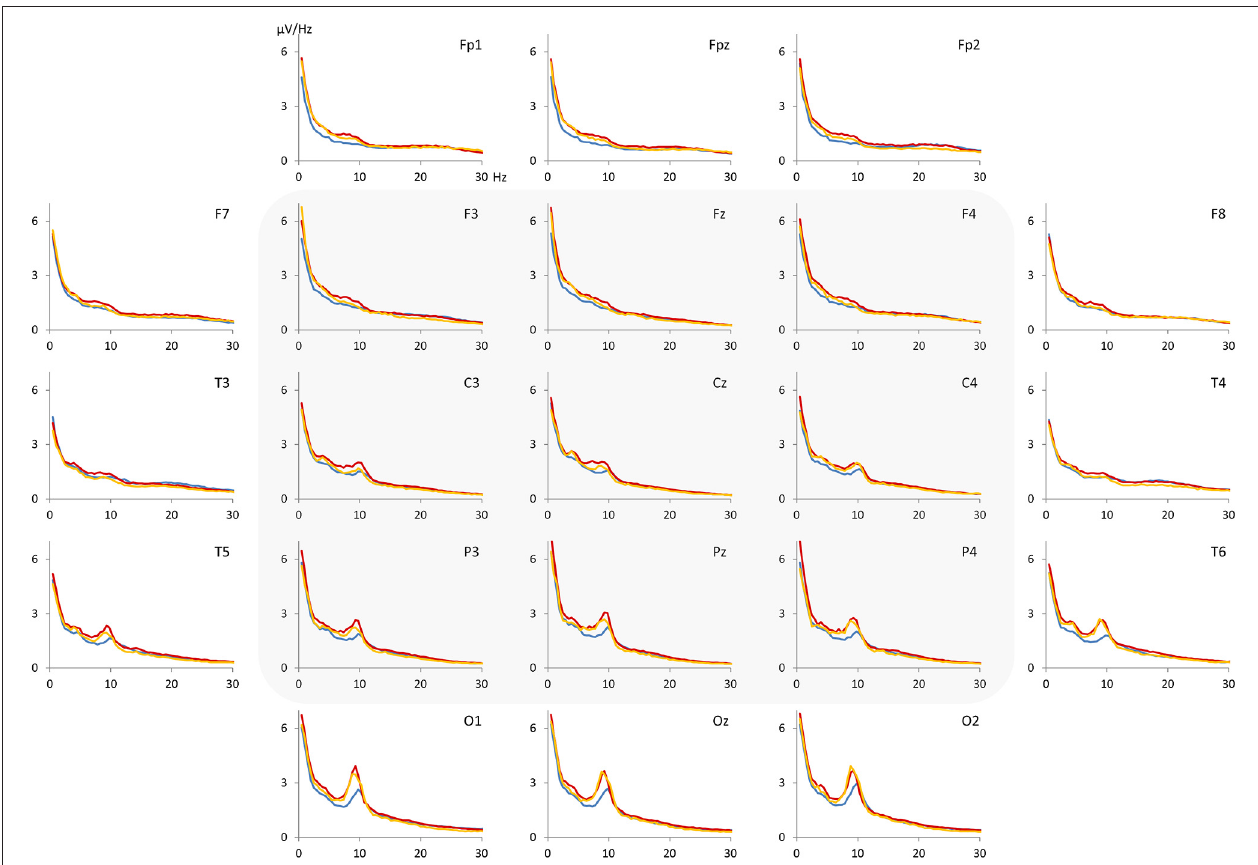
FIGURE 2 | Grand average spectra (voltage density) for control group (blue), ADHD-C group (red) and ADHD-I group (orange) . The most pronounced differences between the groups appear to be in the range of 5.5–10.5 Hz. Electrodes F3, Fz, F4, C3, Cz, C4, P3, Pz and P4 were considered for statistical